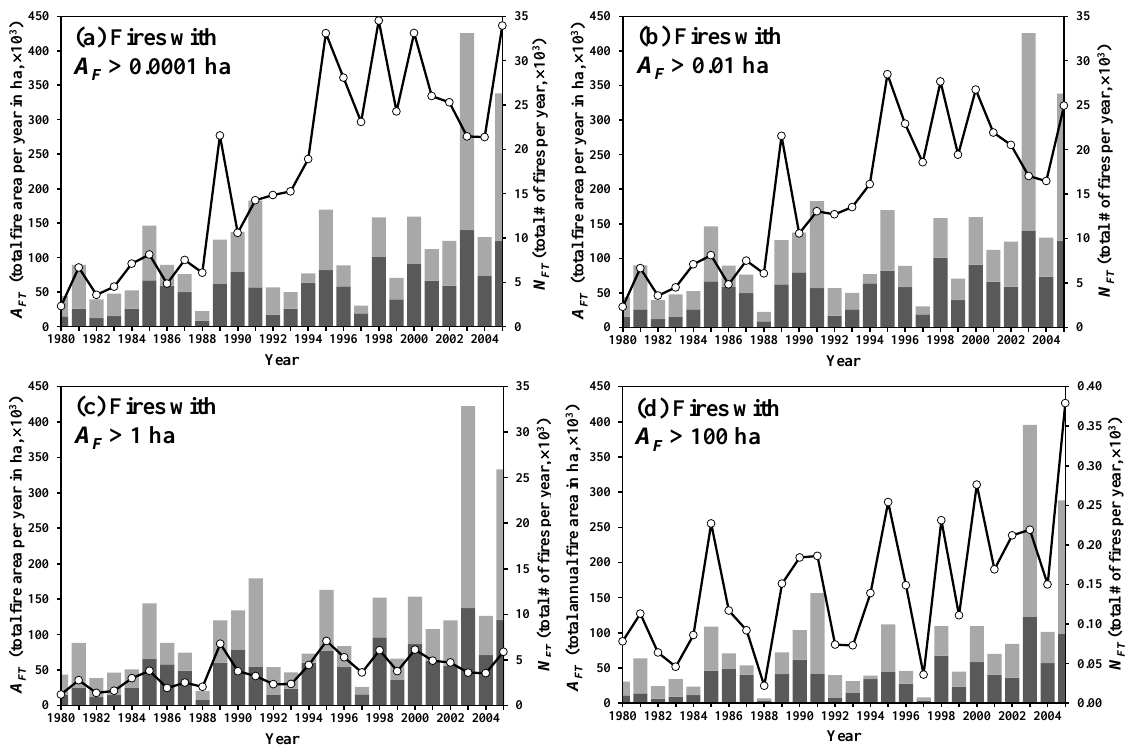
Fig. 4. Temporal evolution of the annual total number ( N FT , solid line) and area ( A FT , vertical bars) of Continental Portugal fire records. The vertical bars are subdivided into burnt area of forests (light grey bars) and shrublands (dark grey bars). Four lower thresholds are included: A F > (a) 0.0001ha, (b) 0.01ha, (c) 1ha and (d) 100ha. The A FT (principal vertical) axis remains the same for all four figure parts, but the secondary vertical axes maximum value changes from N FT = 35000 for (a) , (b) and (c) to N FT = 400 for (d) , thus changing by a factor of about 100 the vertical